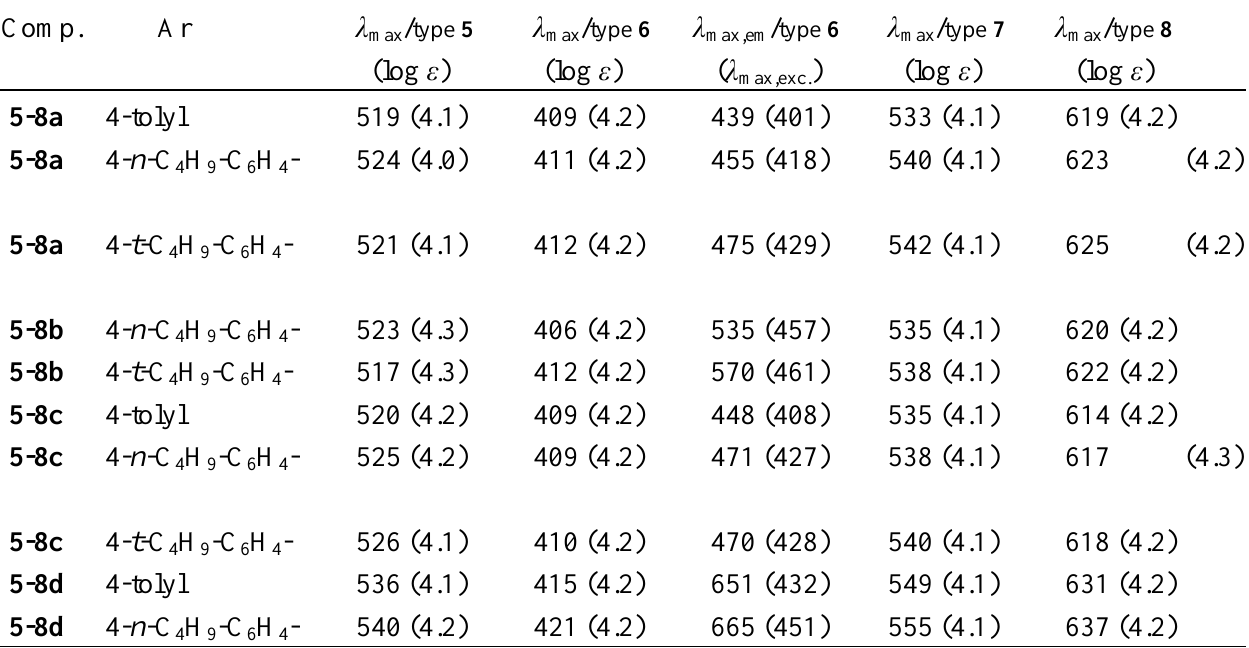
Table 2 : Absorption and emission maxima of reduced 6 , deprotonated 7 and protonated 8 . Comp.